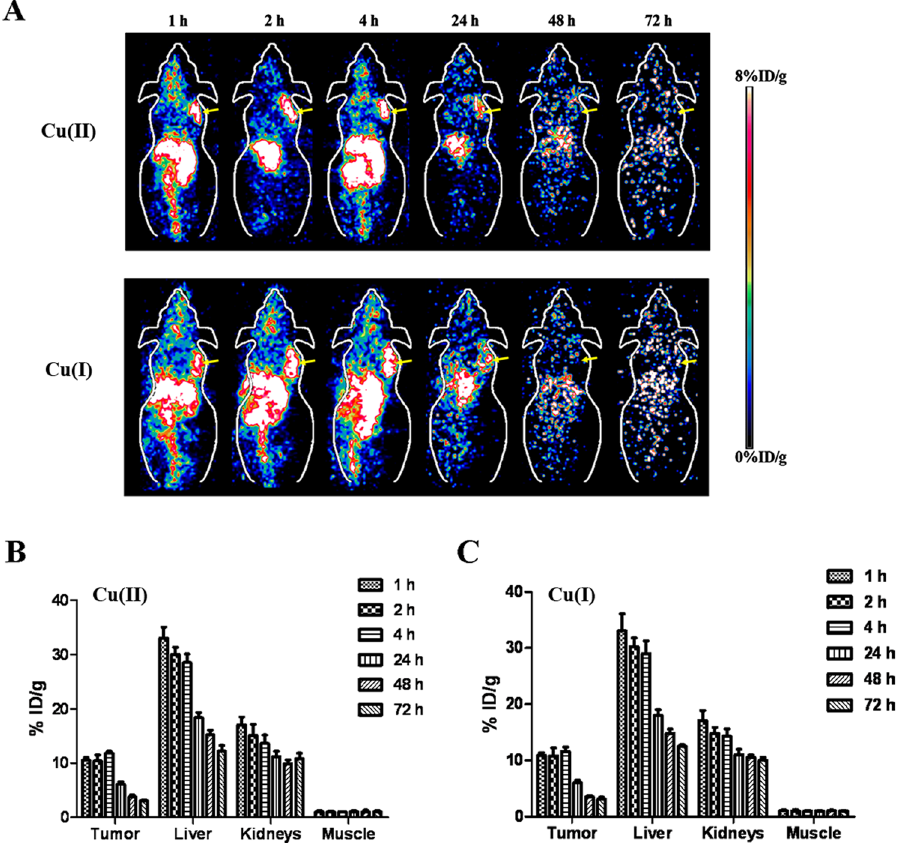
Figure 3. ( A ) Decay-corrected whole-body coronal small-animal PET images of B16F10 tumor-bearing mice at 1, 2, 4, 24, 48, and 72 h after intravenous injection of 64 Cu(II) and 64 Cu(I), respectively (Tumors are indicated by arrows). ( B and C ) Small-animal PET quantification of tumors and major organs (liver, kidney and muscle) at 1, 2, 4, 24, 48, and 72 h after injection of 64 Cu(II) and 64 Cu(I), respectively (n =